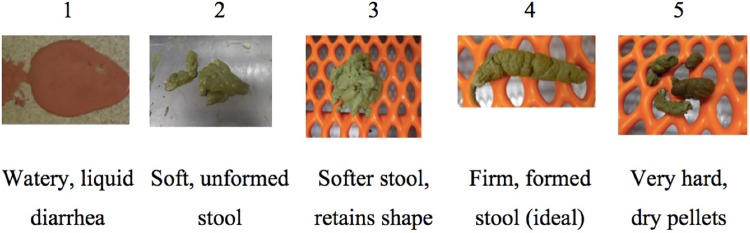
Oxygen radical absorbance capacity (ORAC) of plasma collected from dogs at the end of each period fed control (CON), whole sorghum (WSD), sorghum flour (FLD) and sorghum mill-feed (MFD) diets (N = 12; P < .0001).TE = Trolox equivalent. abMeans within a row that lack a common superscript differ (P < 0.05).